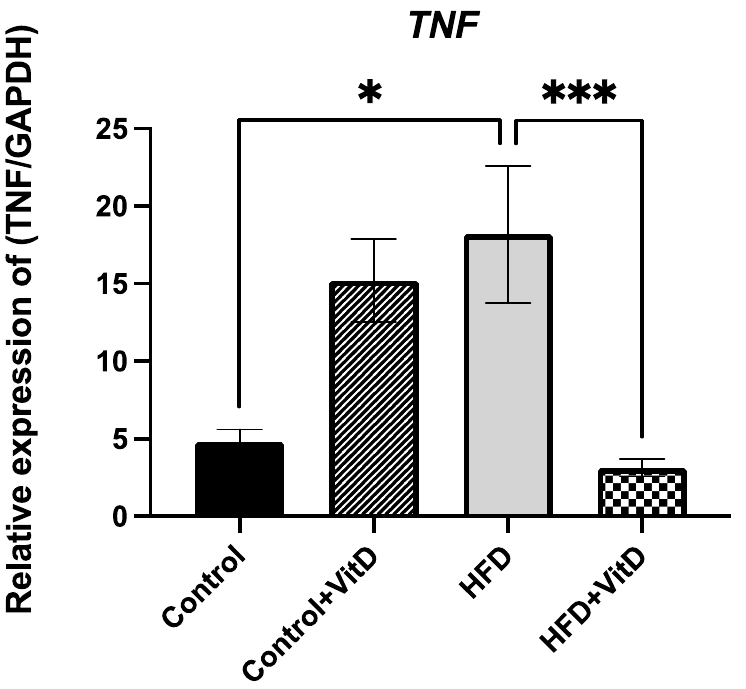
Figure 3. Tumor necrosis factor ( TNF- α ) gene expression. The high-fat diet (HFD) increased the expression of TNF α significantly ( p = 0.03) compared to the control, whereas VitD supplementation with the HFD significantly decreased the expression of TNF α ( p = 0.0006). Data were normalized to the reference gene GAPDH. All data were expressed as mean ± SEM. Data were considered significant if * p < 0.05, *** p < 0.001.